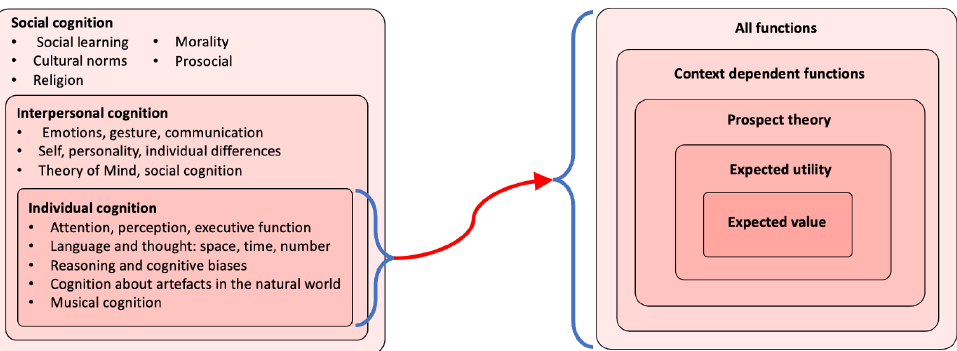
Figure 1. ( Left ) a simplified form of the psychological framework of Barrett [6] illustrating the multi- modal nature of cognition, the individual, the interpersonal, and the social. ( Right ) A simplified form of Peterson et al.’s [7] layering of cognitive models for AI. Note that this is, in part, an AI representation of well known socio-economic decision